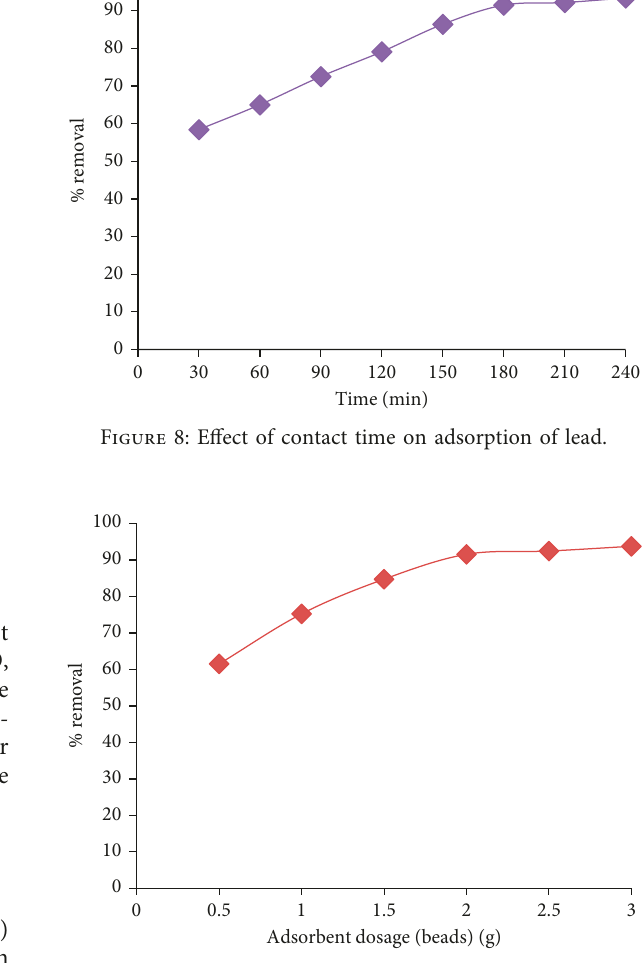
Figure 9: Effect of sorbent dosage on adsorption of